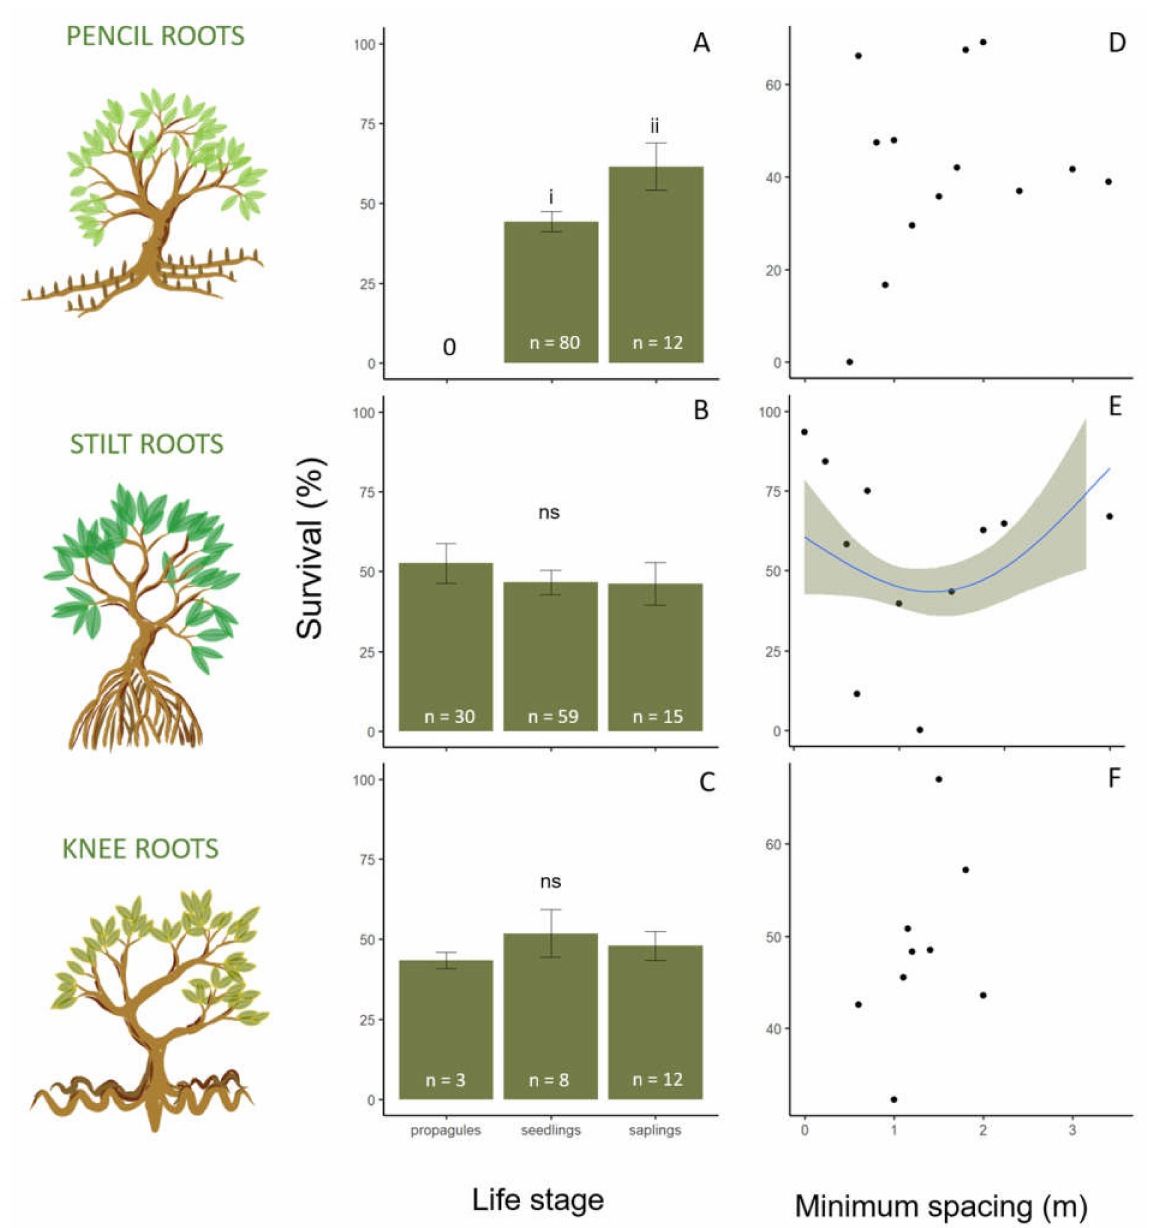
Figure 3. Influence of life stage and spacing on survival rates for mangrove planting projects involving species that have pencil roots ( Avicennia and Sonneratia ), stilt roots ( Rhizophora ) and knee roots ( Bruguiera and Ceriops ). Data are means ± SE for life stage ( A – C ) and smooth splines (partial plots) for spacing ( D – F ). Different roman numerals signify statistically significant differences among fixed factors, and ‘ns’ = no significant